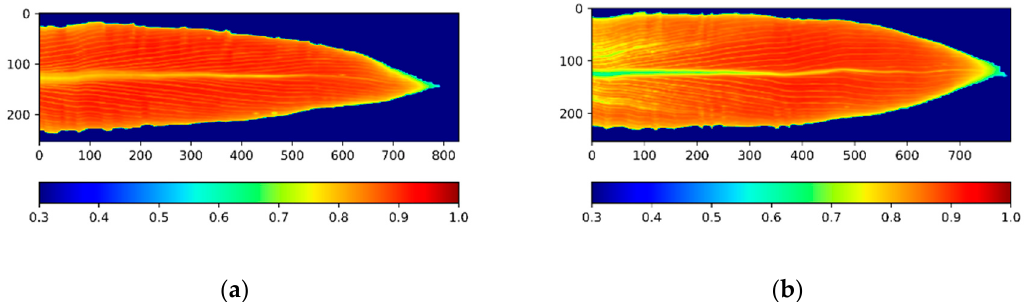
Figure 3. The Normalized Di ff erence Vegetative Index (NDVI) image of the top-collared leaves of corn plants under di ff erent nitrogen deficiencies at the V8 stage. ( a ) High nitrogen treatment; ( b ) Low nitrogen treatment. The NDVI image followed the expected impacts from nitrogen stresses.